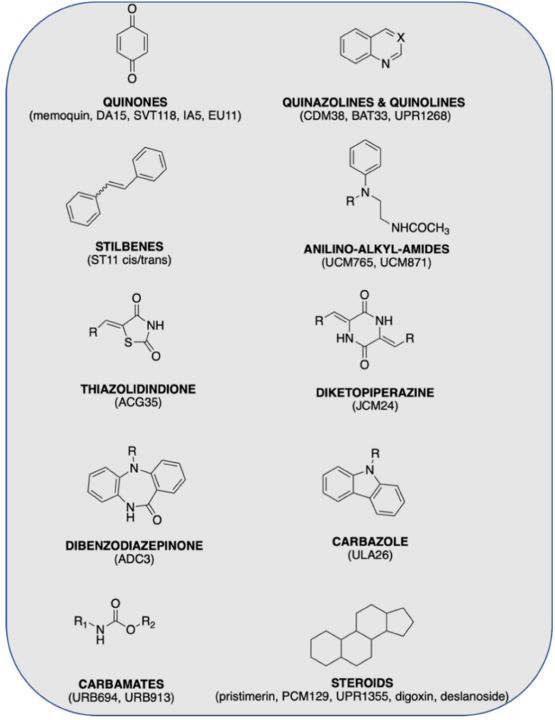
Figure 2. Scaffolds featuring the in-house repurposing